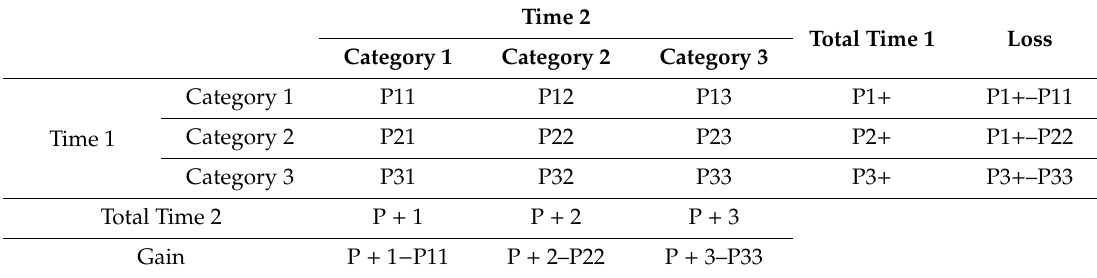
Table 1. Cross-tabulation